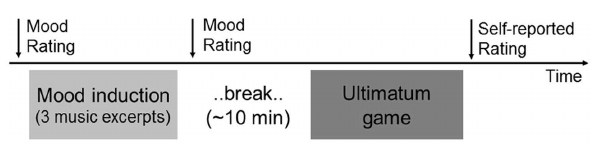
FIGURE 1 | Time course of mood induction and ultimatum game